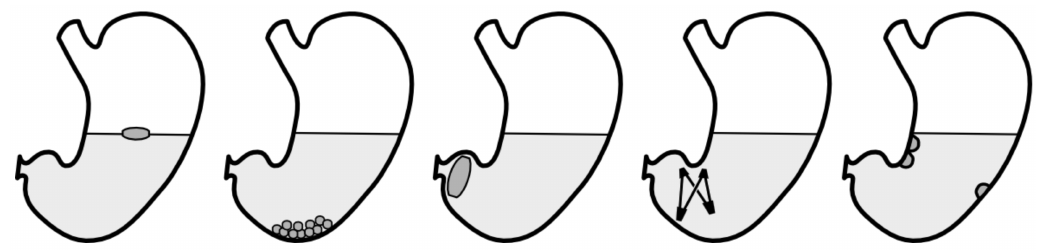
Figure 4. Schematic of the most common approaches to achieve gastroretention. From left to right: floating, sedimentation, expansion (swelling), expansion (unfolding),